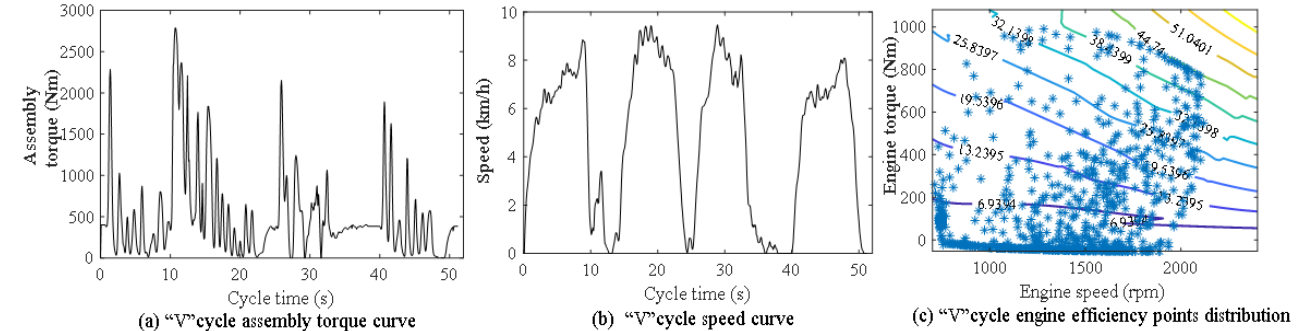
Figure 3. Operation characteristics of a loader under “V” cycle.